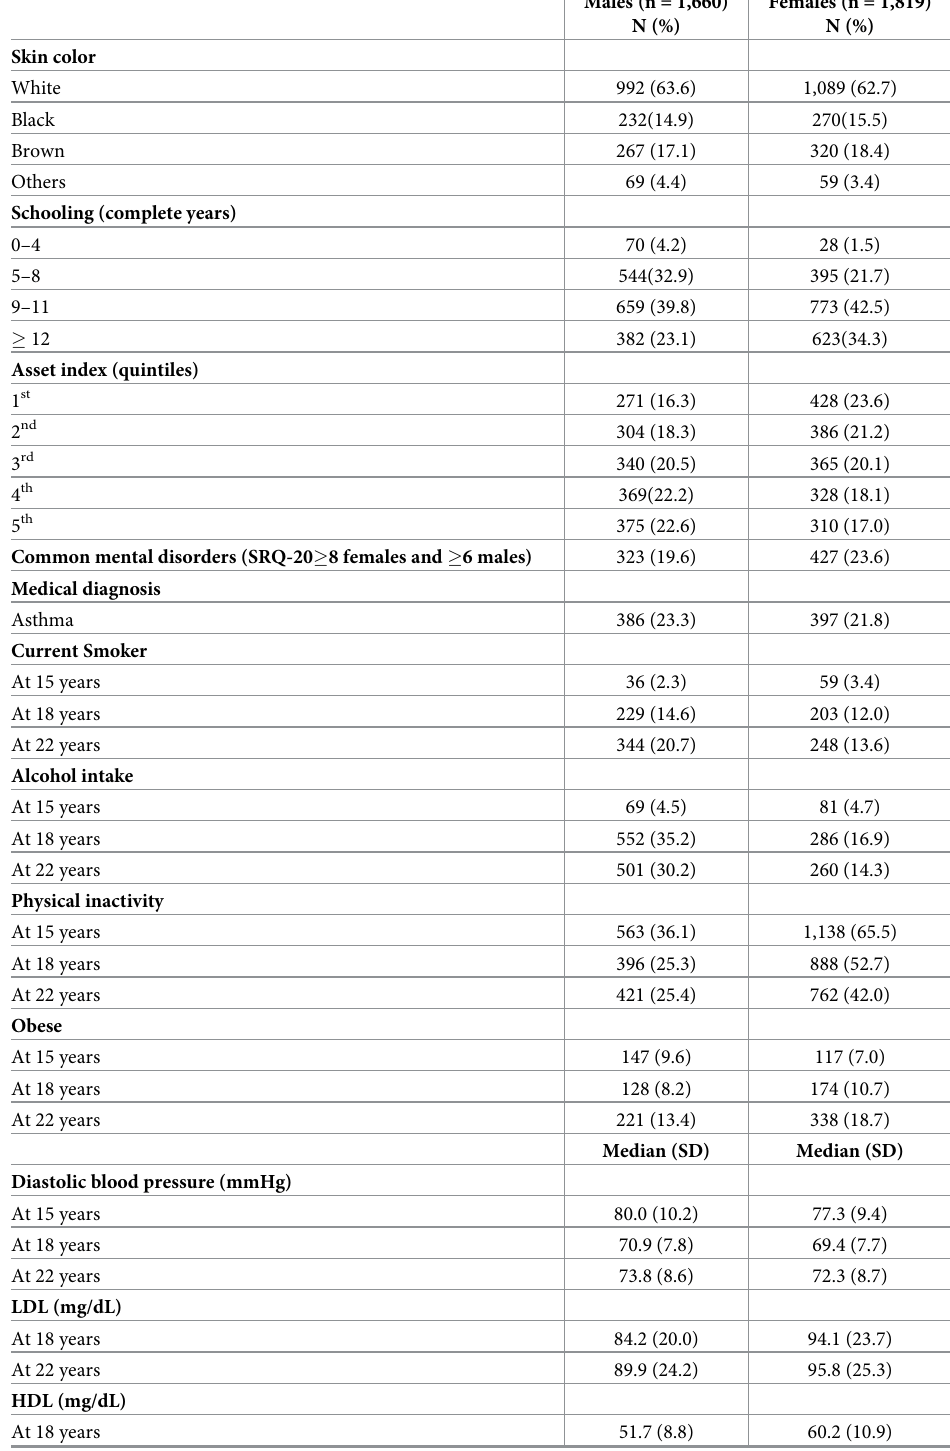
Table 1. Sample description (individuals with 22 years old interleukin-6, C-reactive protein and/or adiponectin information) according to demographic, socioeconomic and health variables, stratified by sex (n = 3,479). The 1993 Pelotas Birth